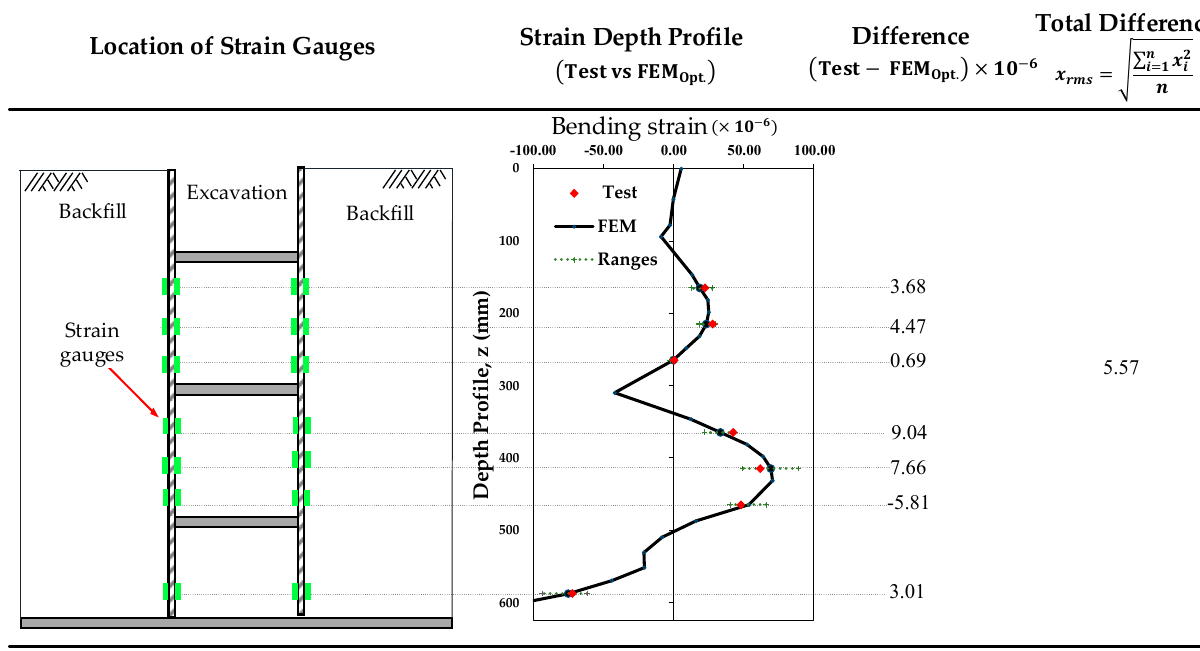
Figure 10. Updated numerical model and test result comparison.